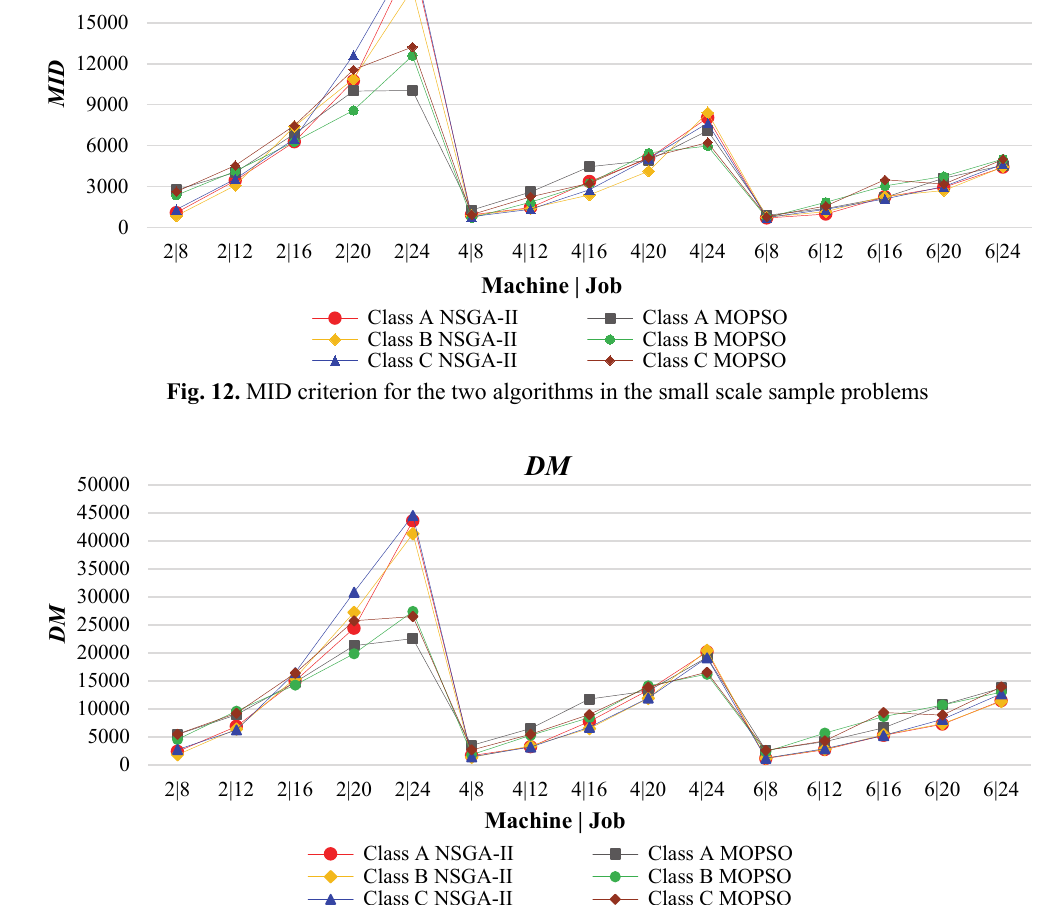
Fig. 13. DM criterion for the two algorithms in the small scale sample